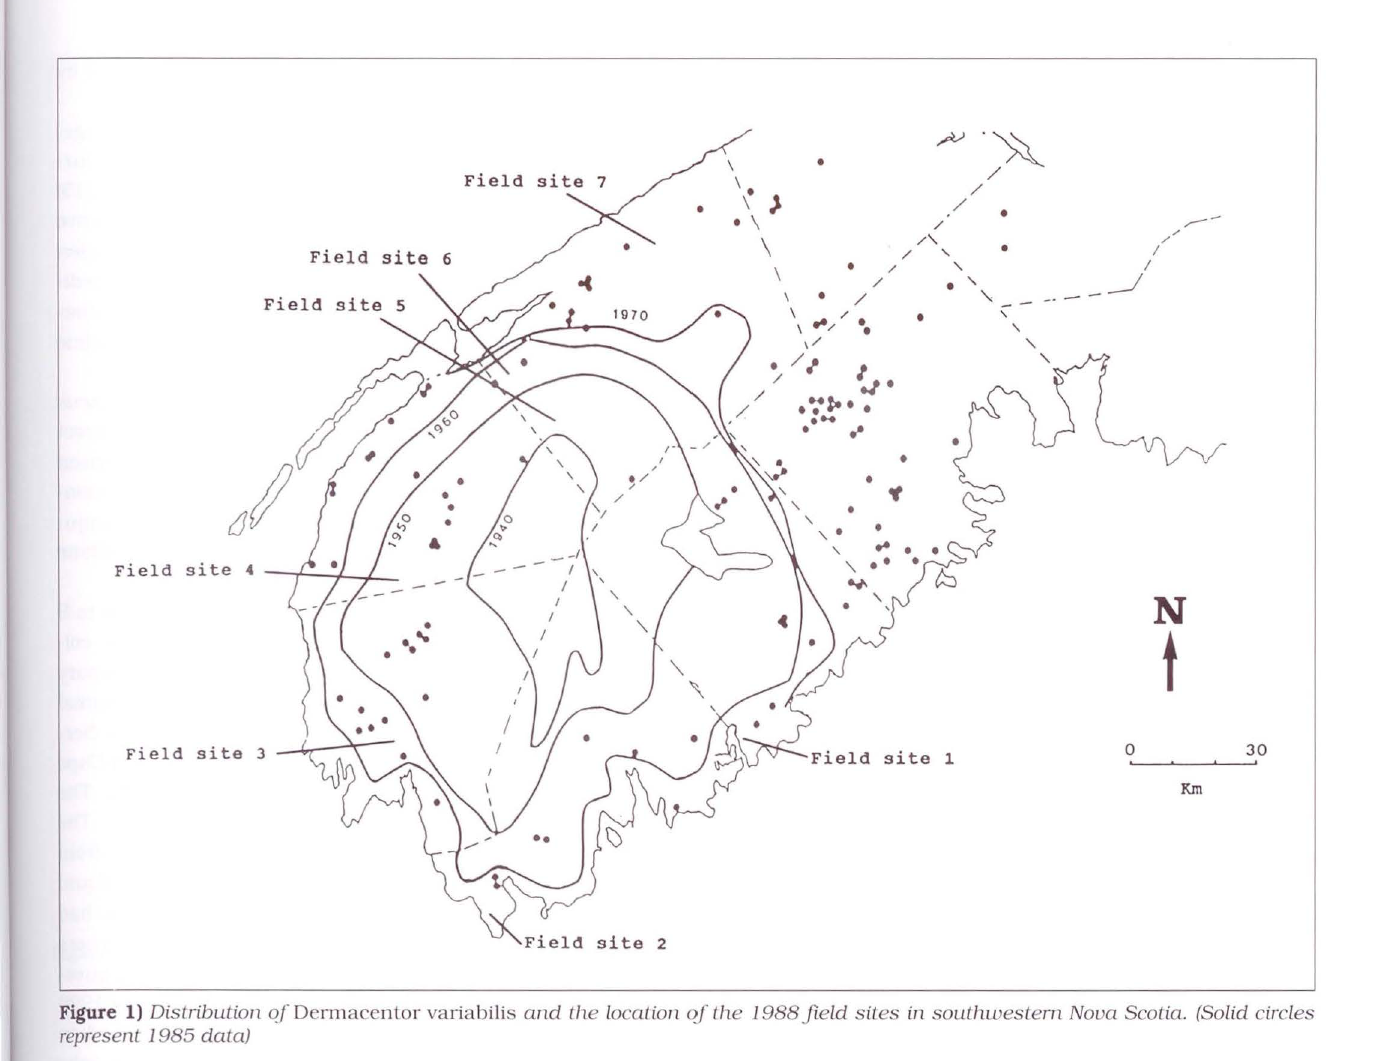
Figure 1) Distribution qf Dermacentor variabilis and the location of lhe 1988 field sites in sotllhwestern Nova Scotia. (Solid circles represent 1985